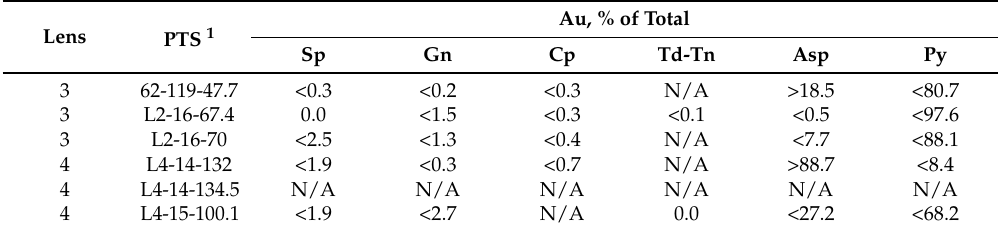
Table 7. Gold distributions by grain